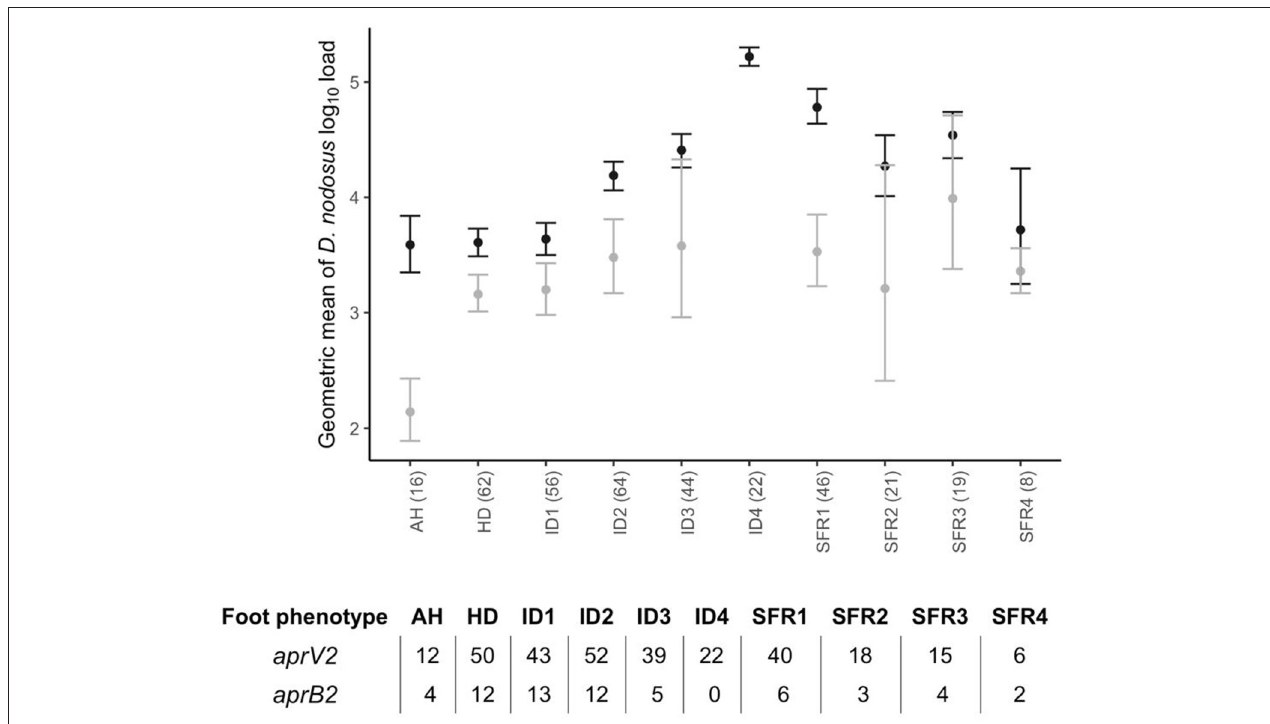
FIGURE 4 | Geometric mean and 2 standard errors for log 10 aprV2 D. nodosus load (black) and log 10 aprB2 D. nodosus load (grey) by foot phenotype from 395 samples from 24 flocks in England with clinical footrot. AH, all healthy feet from sheep where all four feet were healthy; HD, Healthy feet from sheep where one or more feet had signs of footrot; ID, Interdigital dermatitis scores 1–4; SFR, Severe footrot scores 1–4. Number in brackets after each foot phenotype on the x-axis is the total number of pooled swabs positive for aprV2 or aprB2 in each foot phenotype category. The associated table shows the split between samples aprV2 or aprB2 positive out of total number positive.